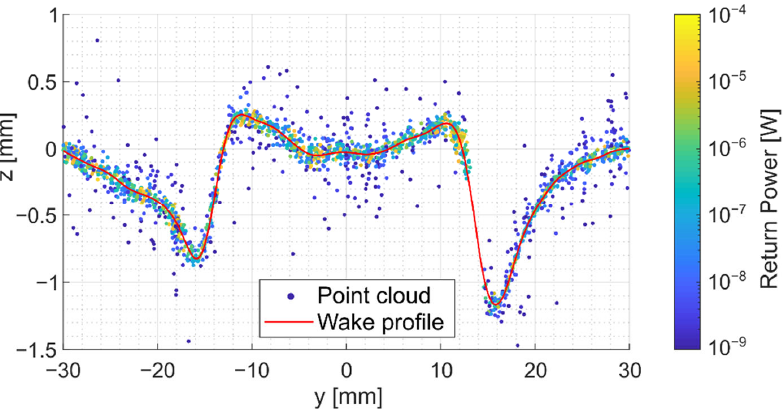
Figure 7. Point cloud of a plate with an idealized wake profile and small surface waves with an amplitude of A = 0.28 mm.